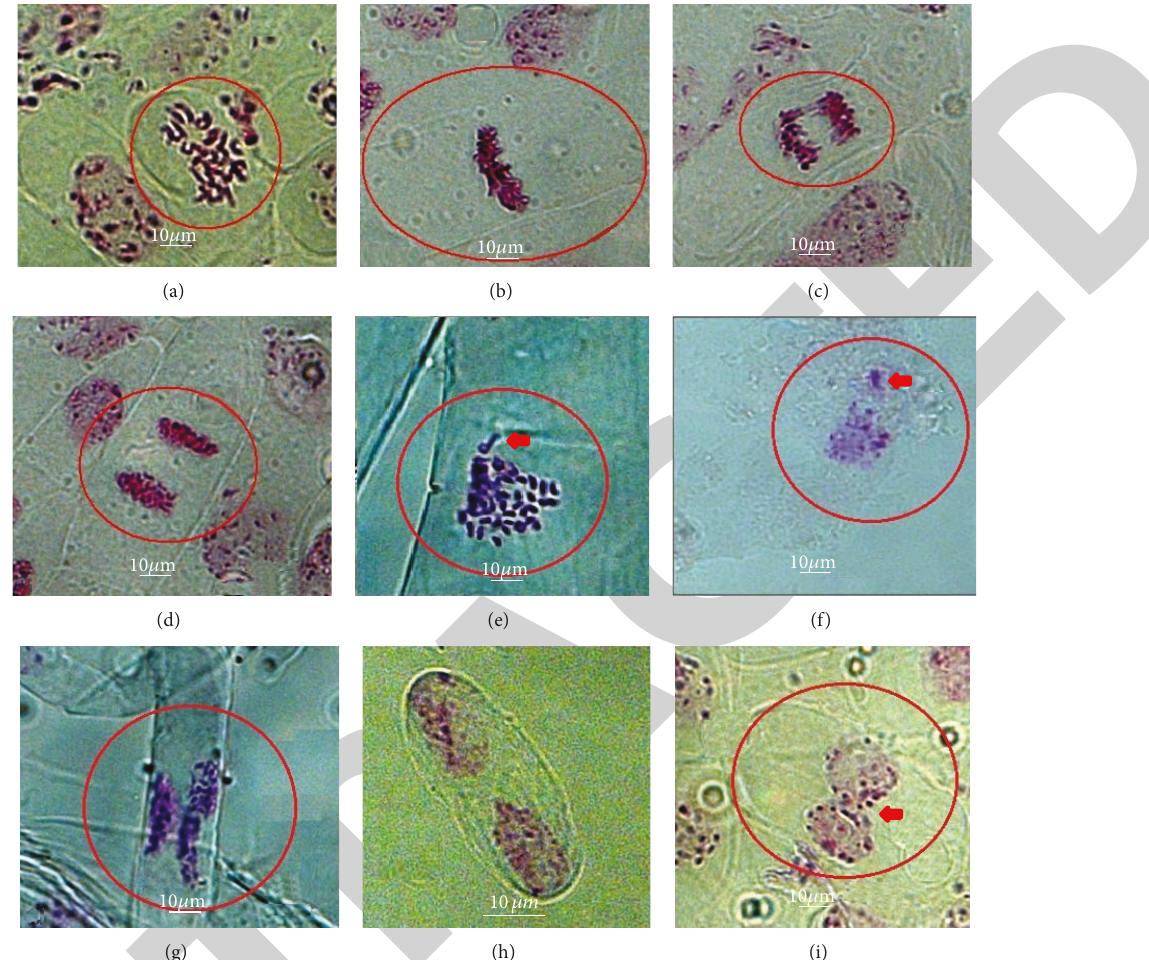
Figure 5: Root meristem cells of O. viciifolia showing normal and abnormal mitosis. (a) prophase, (b) metaphase, (c) anaphase, (d) telophase, (e) fragmented chromosomes, (f) micronucleus, (g) asynchronous nucleus, (h) binucleated cells, and (i) cytomixis. Bars = 10 𝜇 m.